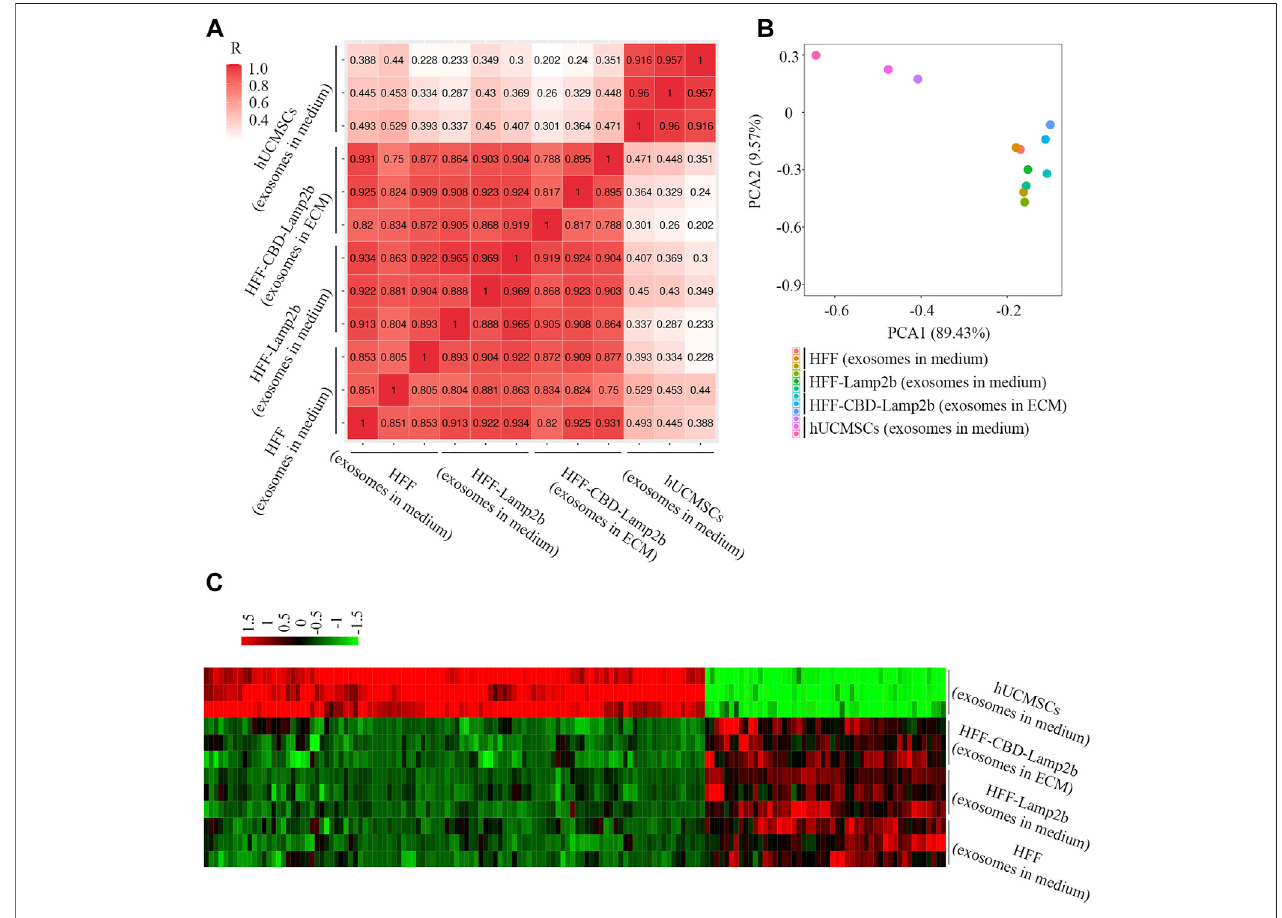
FIGURE 4 | The comparison of exosomal miRNAs from ECM or media derived from HFF-CBD-Lamp2b cells, HFF cells, HFF-Lamp2b cells and hUCMSCs. (A) Spearman ’ scorrelationanalysis. (B) PrincipalcomponentanalysiswasusedtoinvestigatethedifferencesofexosomalmiRNAfromindicatedsamples. (C) Theheatmap was used to show the expression of different miRNAs from indicated samples (red color means upregulation; green color means downregulation).